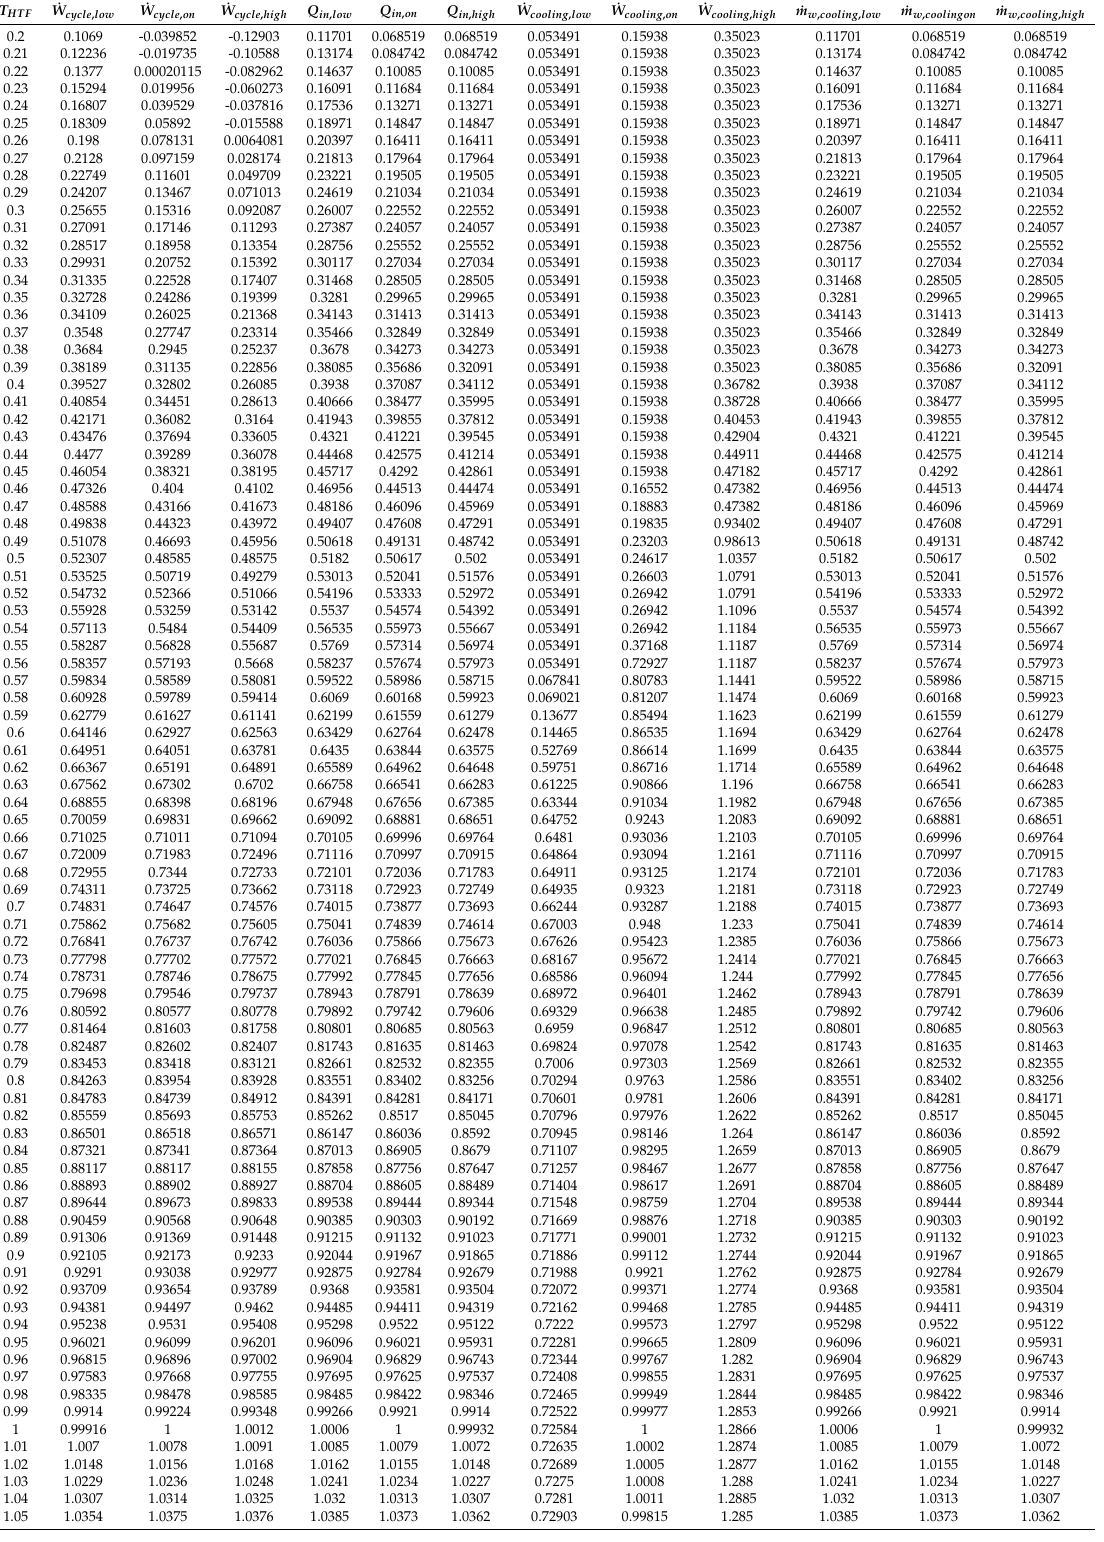
Table A2. Performance as a function of HTF mass flow rate (MOD2) table for Allam cycle. “Low”, “On” and “High” respectively refer to the three values of ambient temperature employed: 5, 15 and 40 º